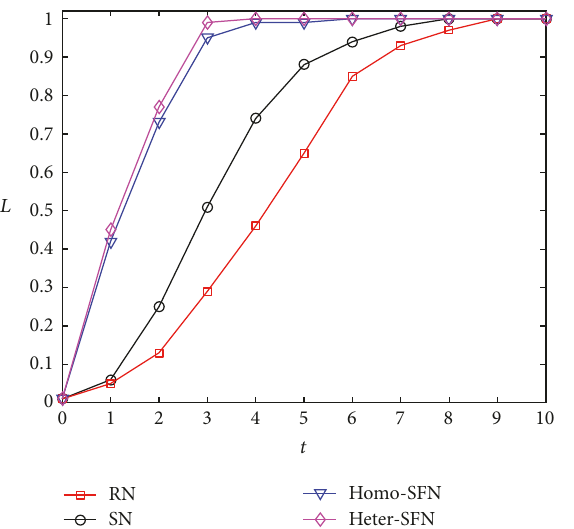
Figure 9: Cascading process under max-degree attack (𝜀 = 0.6) .